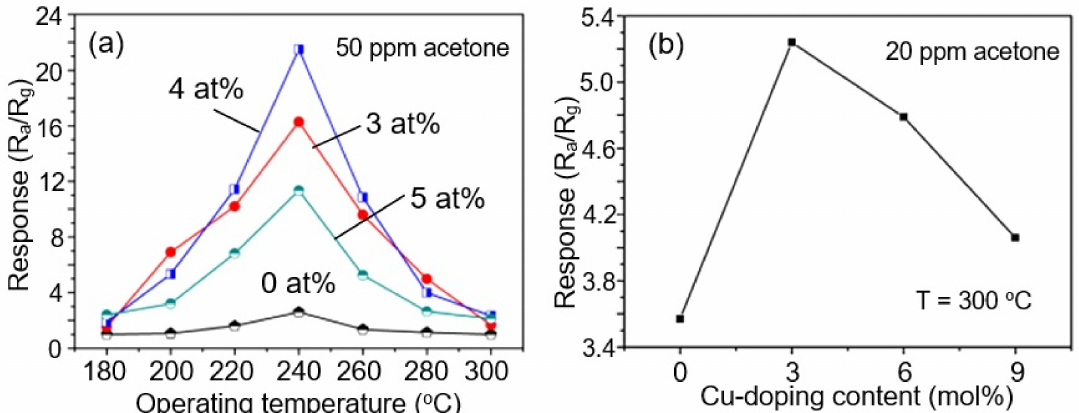
Figure 16. ( a ) Responses of gas sensors based on pristine and Ce-doped (3, 4 and 5 at %) α -Fe 2 O 3 hollow nanofibers to 50 ppm acetone under different temperatures. ( b ) Response values of the pure, 3, 6 and 9 mol% Cu-doped WO 3 hollow fibers to 20 ppm of acetone at T oper = 300 ◦ C. ( a ) Adapted with permission from [238]. Copyright 2014 RSC; ( b ) Adapted with permission from [239]. Copyright 2014